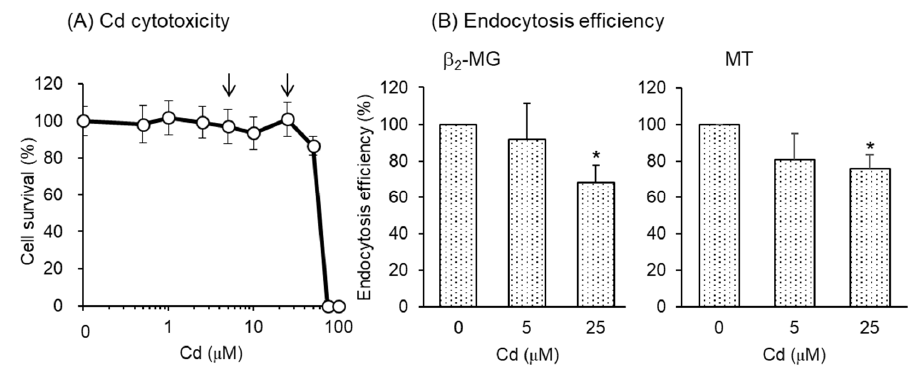
Figure 6. The effects of Cd exposure for 3 days on the endocytosis efficiencies of β 2 -MG and MT into hRPTEC human renal cells. ( A ) Cell viability was determined by alamarBlue assay and expressed as the percentages of the nontreated cells. From these results, the Cd concentrations to be used in the endocytosis experiment were determined (arrows). Data are presented as means ± SD ( n = 4–6). ( B ) The cells were exposed to CdCl 2 for 3 days and then incubated with FITC- β 2 -MG or FITC-MT for 30 min. The endocytosis efficiencies were determined by flow cytometry and expressed as percentages of the control cells (no exposure to Cd). Data are presented as means ± SD ( n = 3–4). Statistical significance of the dose dependence determined by one-way ANOVA was detected in both β 2 -MG ( p < 0.05) and MT ( p < 0.05). Statistical significance compared with the control cells determined by Bonferroni multiple comparisons are indicated as * p < 0.05.